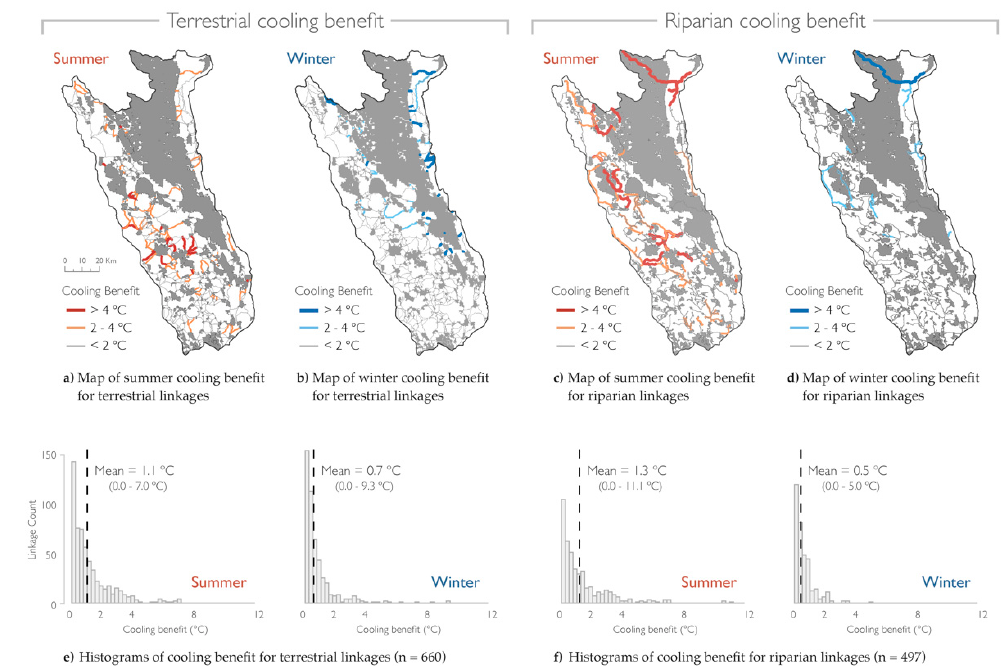
Figure 5. Cooling benefit differed by season for terrestrial and riparian linkages. Maps show the Mayacamas to Berryessa project area and protected areas (gray) overlaid with least cost paths depicting the cooling benefit each linkage was projected to provide at mid-century (2040–2069). On the left are terrestrial linkages with ( a ) summer and ( b ) winter cooling benefit. On the right are riparian linkages with ( c ) summer and ( d ) winter cooling benefit. Linkage width and color saturation increase with cooling benefit in 2 °C increments, ranging from <2 °C (low) to >4 °C (high). Below are histograms showing the cooling benefit by season for ( e ) terrestrial and ( f ) riparian linkages. Units are in degrees Celsius (°C).